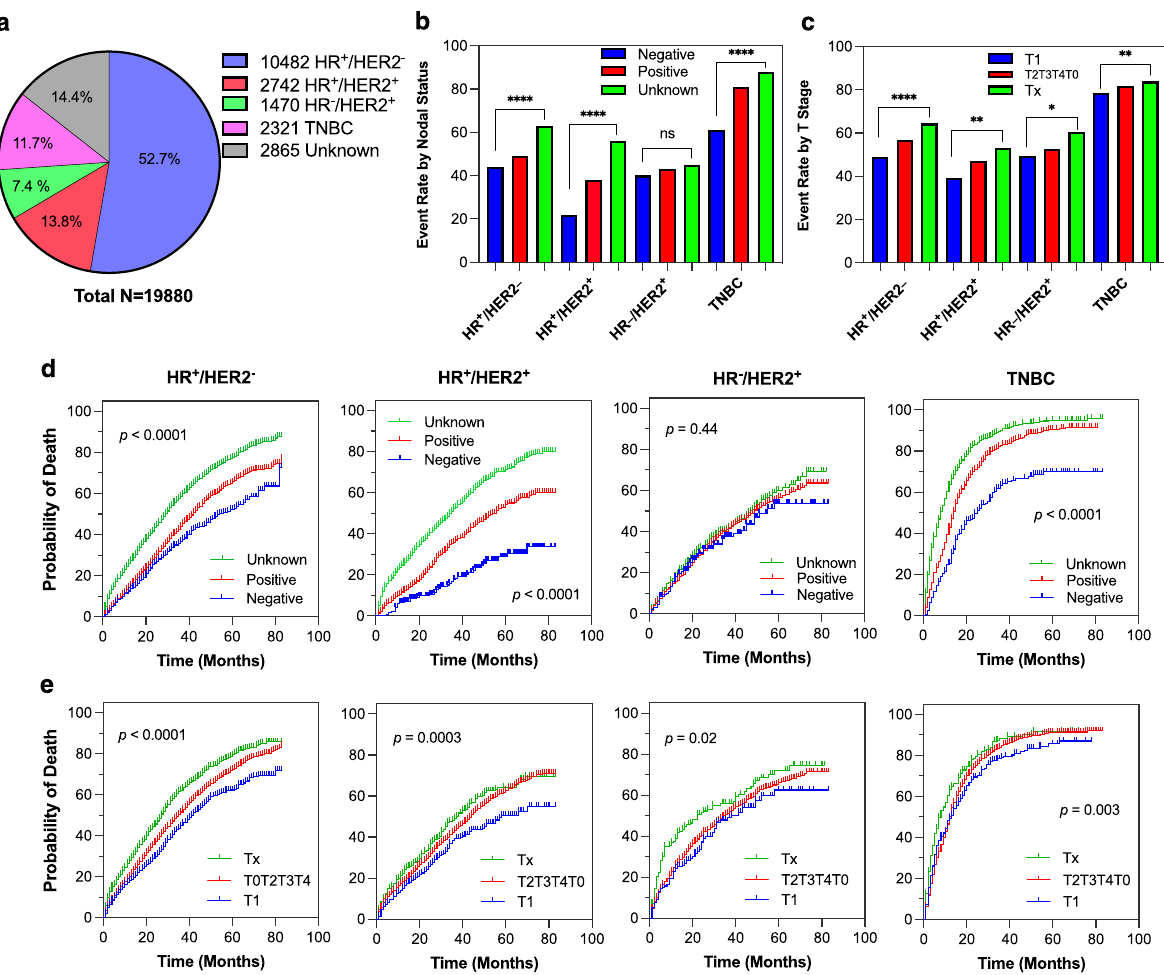
Fig. 4 All-cause death by nodal status and T stage in metastatic breast cancer subtypes. a Number, and percentage of distribution of breast cancer subtypes in de novo metastatic patients. b Event rate by nodal status in HR + /HER2 – , HR + /HER2 + , HR – /HER2 + and TNBC subtypes. c Event rate by T stage in HR + /HER2 – , HR + /HER2 + , HR – /HER2 + and TNBC subtypes. d Kaplan – Meier curves for death strati fi ed by node-negative, node-positive, and node-unknown in the subtypes. e , Kaplan-Meier analysis for death strati fi ed by T1, T2T3T4T0 combined, and Tx in the subtypes. Negative, node-negative; Positive, node-positive, TNBC, triple-negative breast cancer. All determined by log-rank test: * p < 0.05, ** p < 0.01, **** p < 0.0001, and ns, not signi fi